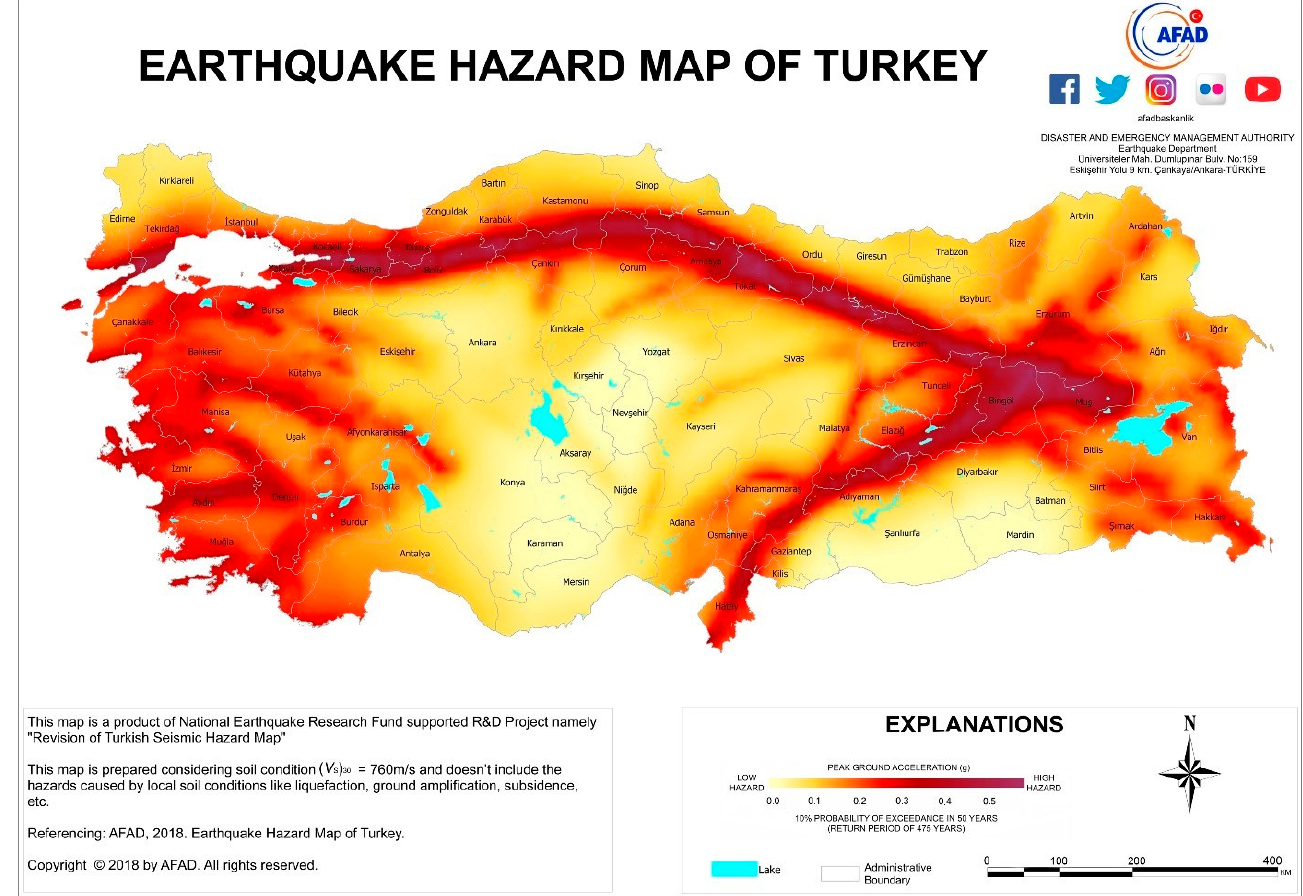
Figure 12. The current earthquake hazard map of Turkey [52].